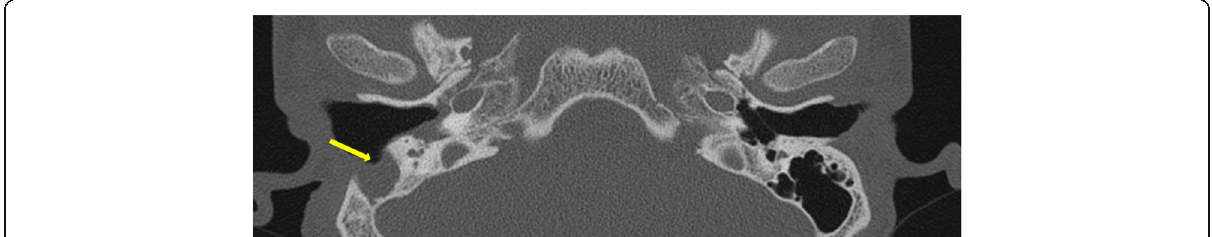
Fig. 12 Axial CT shows the right mastoid cavity filled with soft tissue and is seen to open directly into the external auditory canal suggesting automastoidectomy